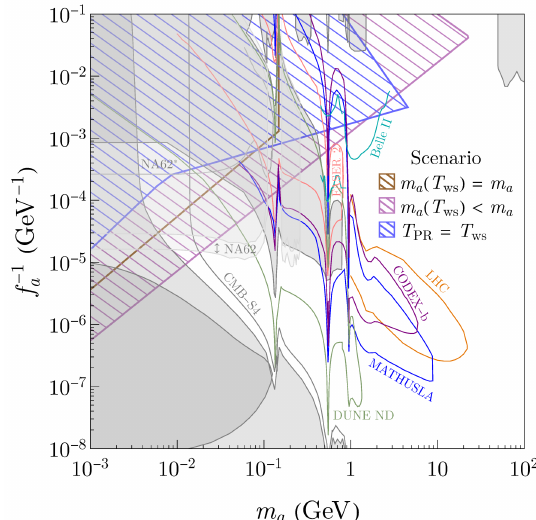
Figure 4 . A summary of viable parameter space shown in the hatched regions in which the baryon asymmetry is successfully reproduced, while different colors of hatching correspond to different models and/or cosmological evolution. The brown and blue hatched regions both assume the axion mass is constant, whereas the brown (blue) region considers the case where parametric resonance occurs after (precisely during) the electroweak phase transition at T ws . The purple hatched region assumes that T PR < T ws but the axion mass evolves with the radial field value S such that m a ( T ws ) < m a and S ( T ws ) > f a . The gray shaded regions are excluded by existing constraints, while the regions enclosed by thin boundaries are within the reach of future experimental